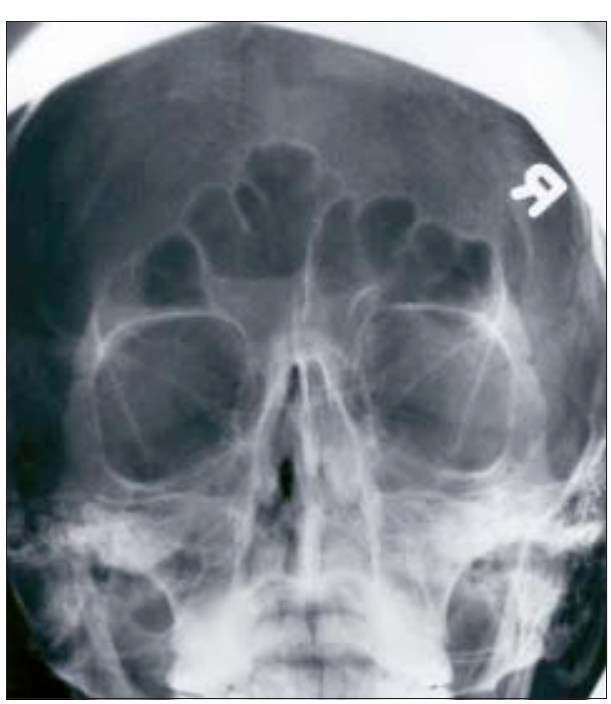
Figure 2) One view of the series of sinus radiographs taken at